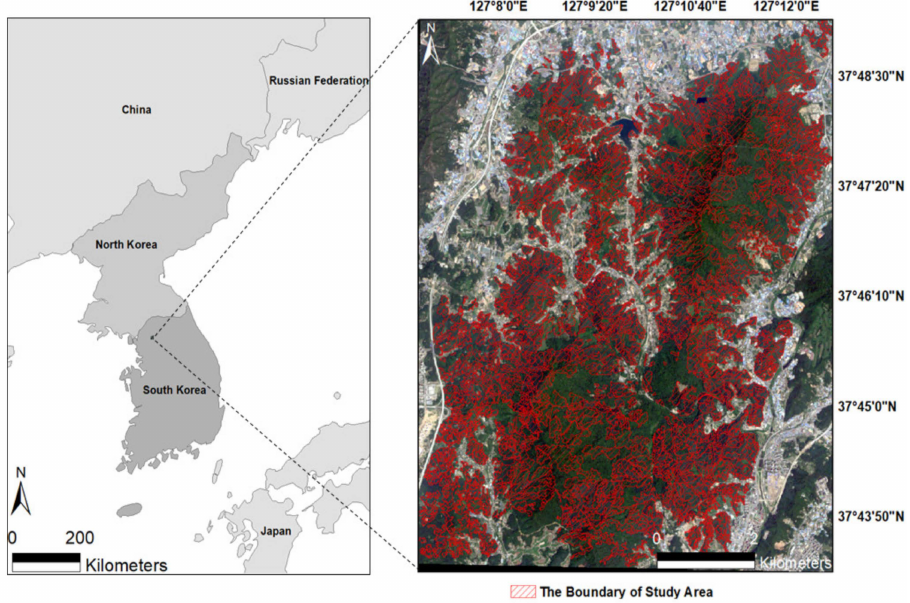
Figure 2. Boundary of study